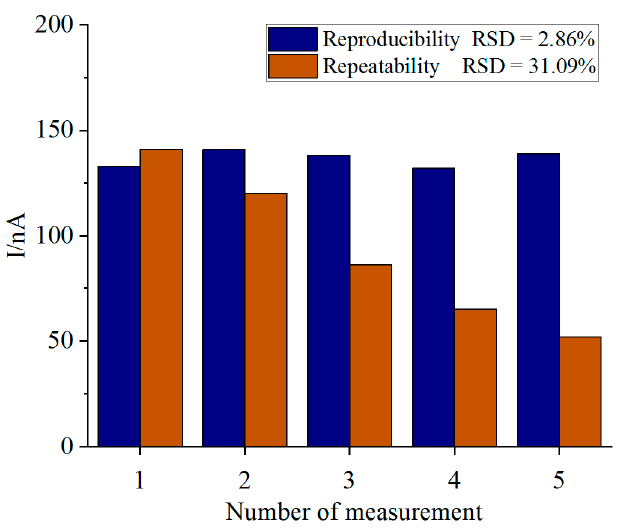
Figure 9. The bar graph showing the reproducibility and repeatability of the biosensor towards 70 μ M NH 4+ at pH 7.5.